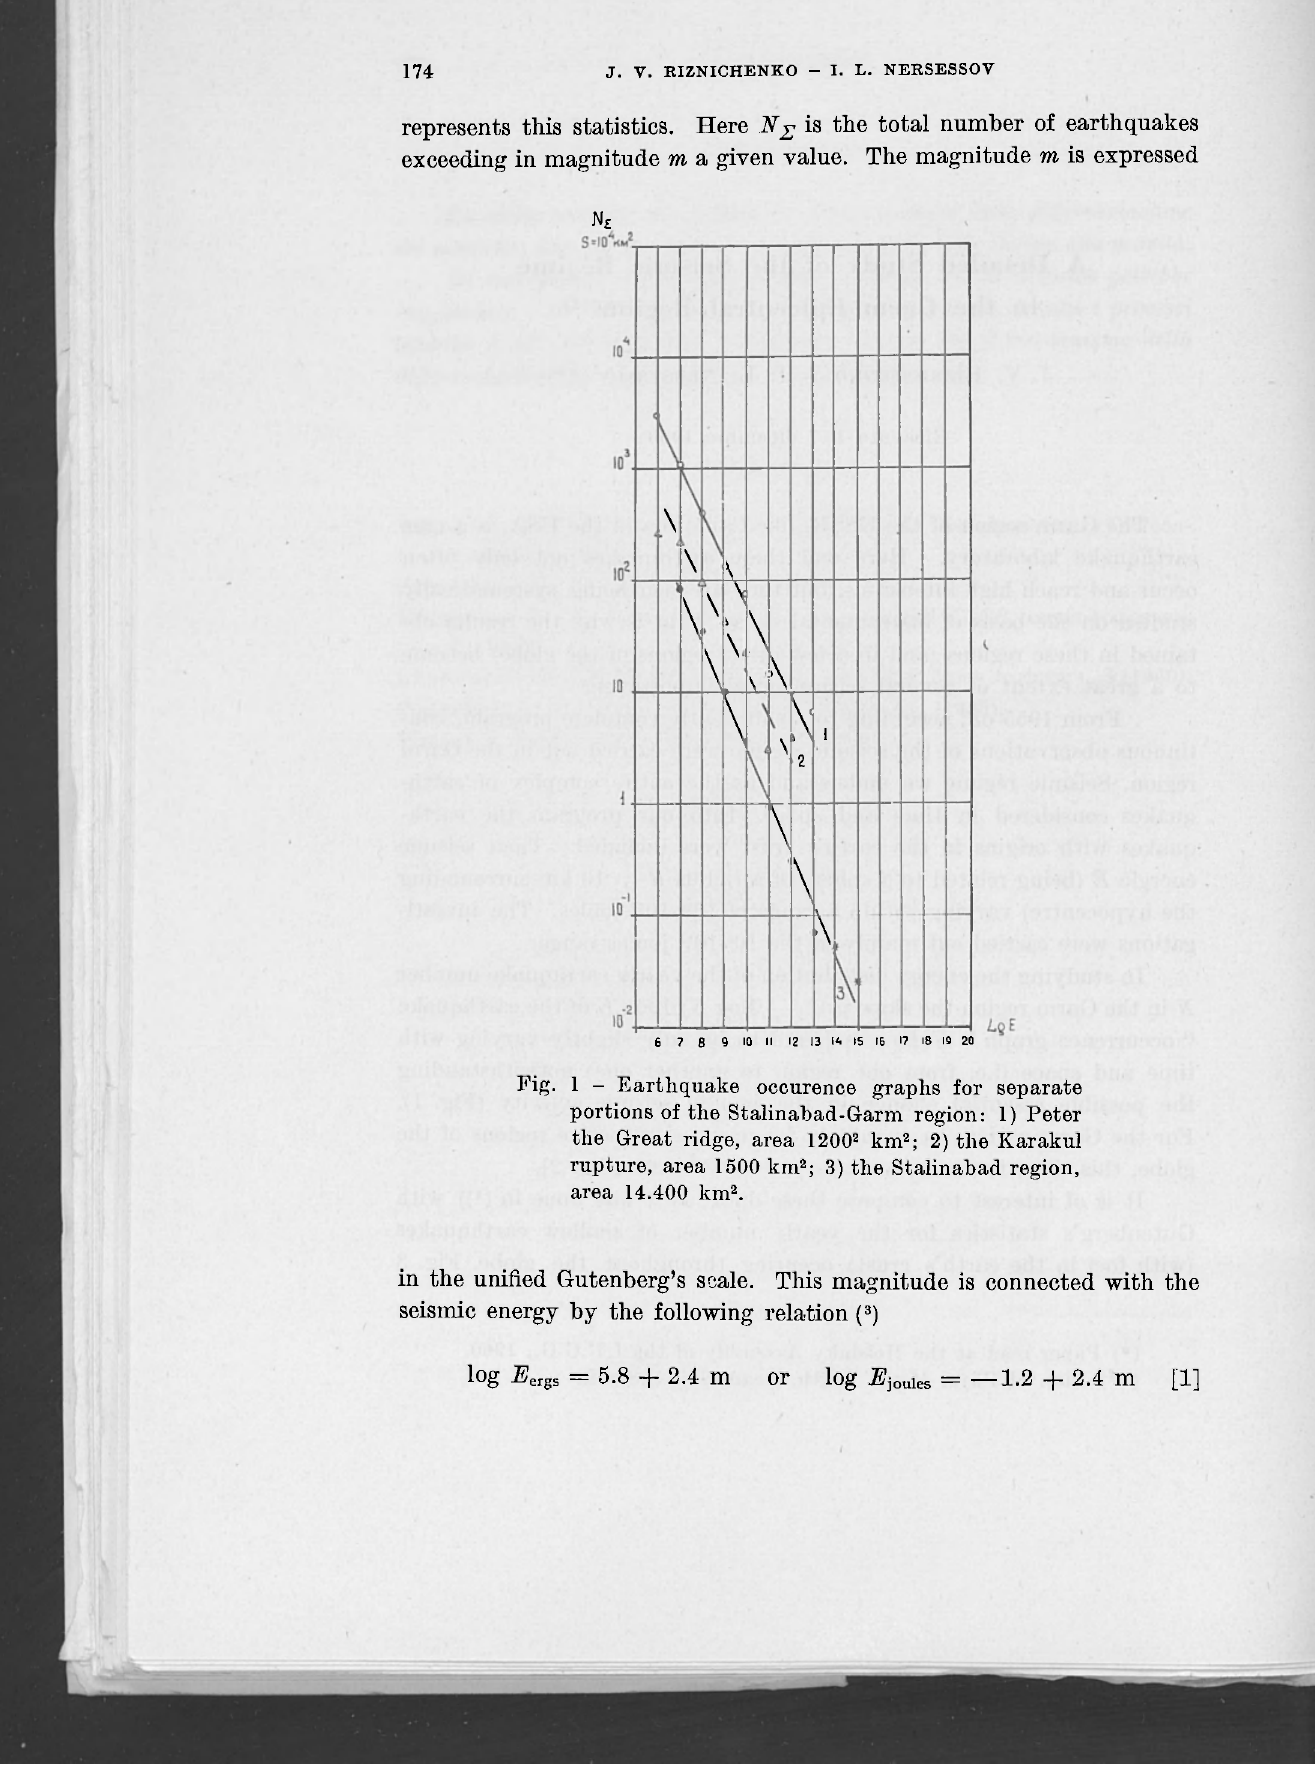
Pig. 1 - Earthquake occurence graphs for separate portions of the Stalinabad-Garm region: 1) Peter the Great ridge, area 1200 3 km 2 ; 2) the Karakul rupture, area 1500 km 2 ; 3) the Stalinabad region, area 14.400 km 2